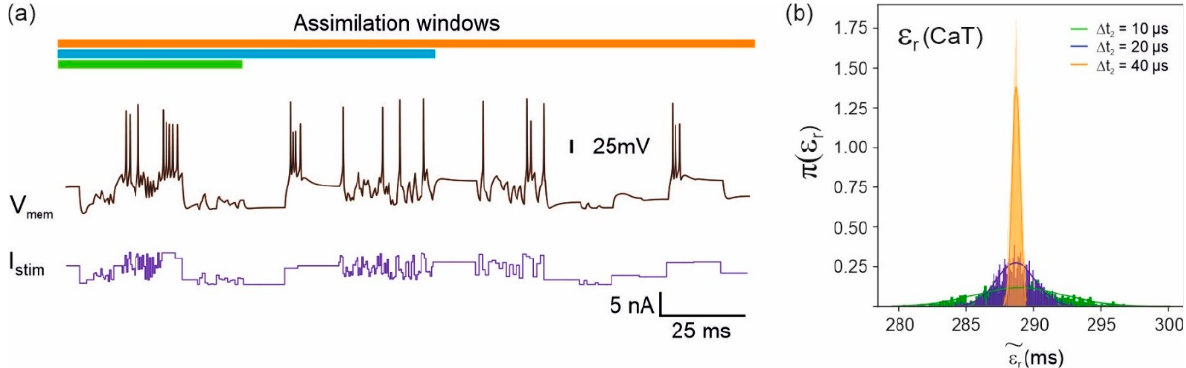
Figure 2. Effect of the length of the data assimilation window on parameter accuracy. ( a ) The model data (black line) were obtained by stimulating the model equations with the current protocol (blue line). A small amount of Gaussian noise was added to introduce uncertainty in the parameters inferred back from the data. Parameters were estimated from three assimilation windows of increasing duration but incorporating the same number of data points, thanks to an adaptive step size ∆ t 2 applied to subthreshold oscillations. ( b ) Posterior distribution functions of one model parameter (gate recovery time constant) corresponding to the three assimilation windows [11].